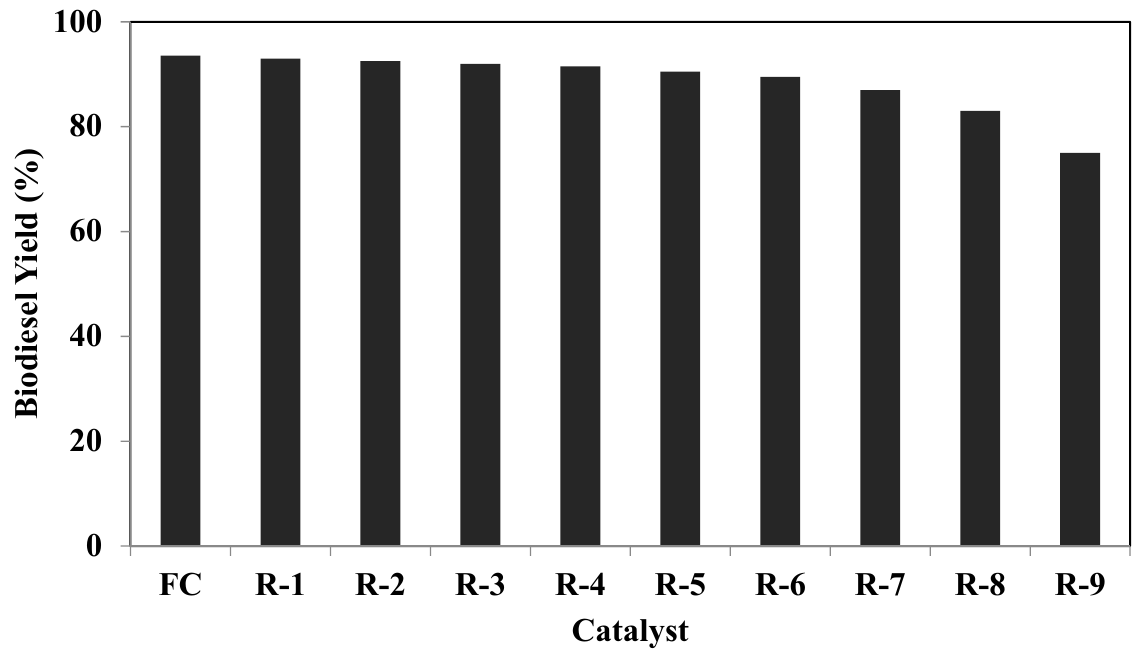
Figure 7. The catalyst reusability for the biodiesel yield for a fresh catalyst (FC) and used up to 10 experimental runs.